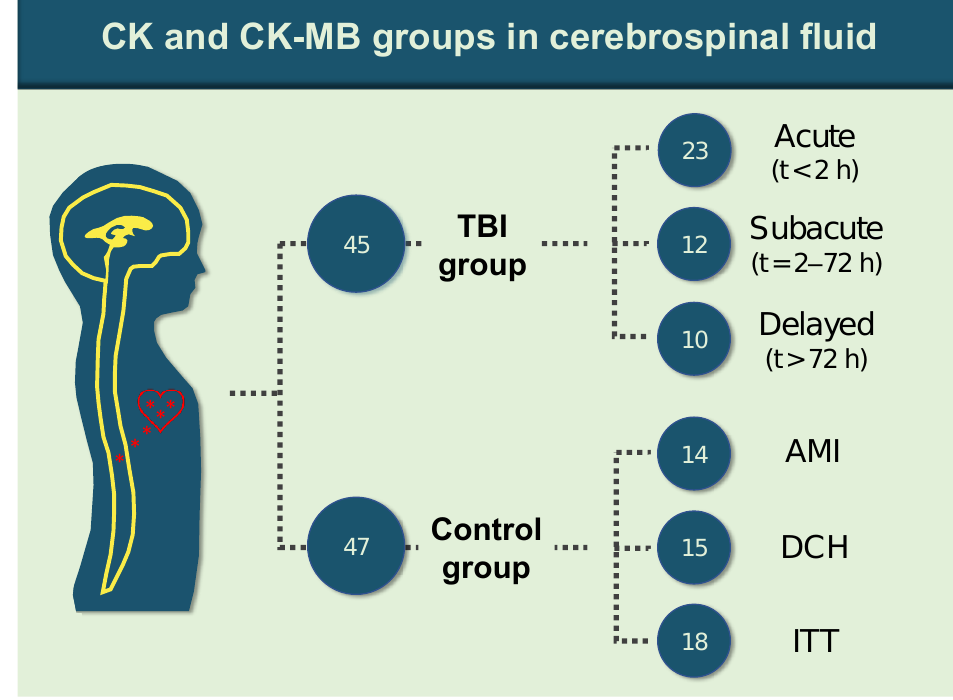
Figure 1. Allocation of postmortem CSF CK and CK – MB samples to TBI and control subgroups ( AMI, acute myocardial infarction; DCH, diffuse cerebral hypoxia; h, hours; ITT, isolated torso trauma; TBI, traumatic brain injury; t, survival time).